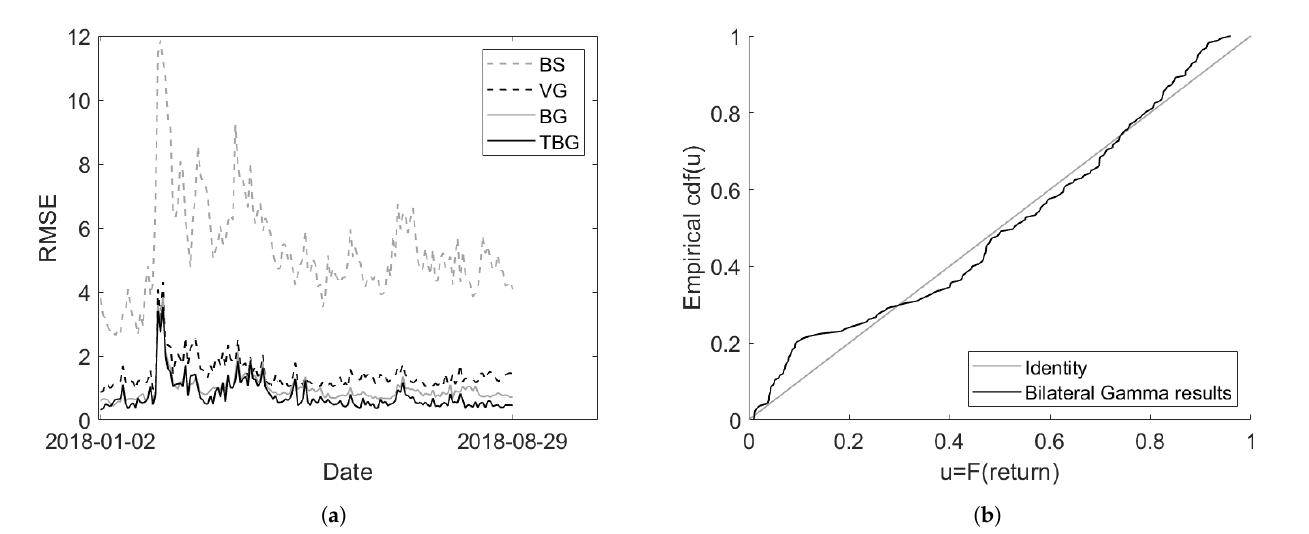
Figure 2. ( a ) Evolution of the RMSE over time between optimal Black-Scholes, Variance Gamma, Bilateral Gamma and Tilted Bilateral Gamma model prices and market prices of plain-vanilla options on the S&P500 index. A calibration is conducted on each business day between 2 January 2018 and 29 August 2018. ( b ) Empirical, physical cumulative distribution function under the Bilateral Gamma model, evaluated at the true monthly return of the S&P500 index, in comparison with the identity function as being the cumulative distribution function of a uniform random variable. ( a ) Evolution RMSE; ( b ) Quality of BG. Table 2. Calibrated values on 15 March 2018, for the parameters of the Tilted Bilateral Gamma model as set in Equation (32). The time series average, minimum and maximum value is also added. Average values are determined as the mean parameter values across all calibration